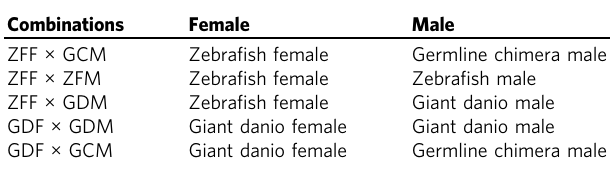
Table 2 Combinations of fertilization trials between the germline chimeras and the control